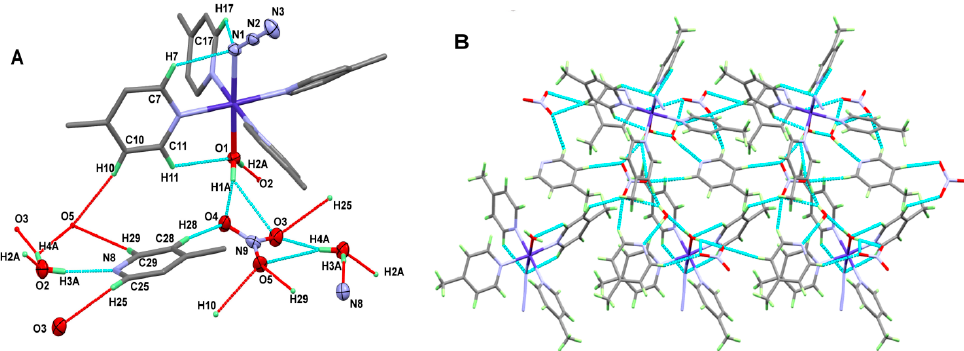
Figure 3. H-bridge contacts ( A ) and H-bonding network ( B ) in 1 . Table 3. Hydrogen bonds in complex 1